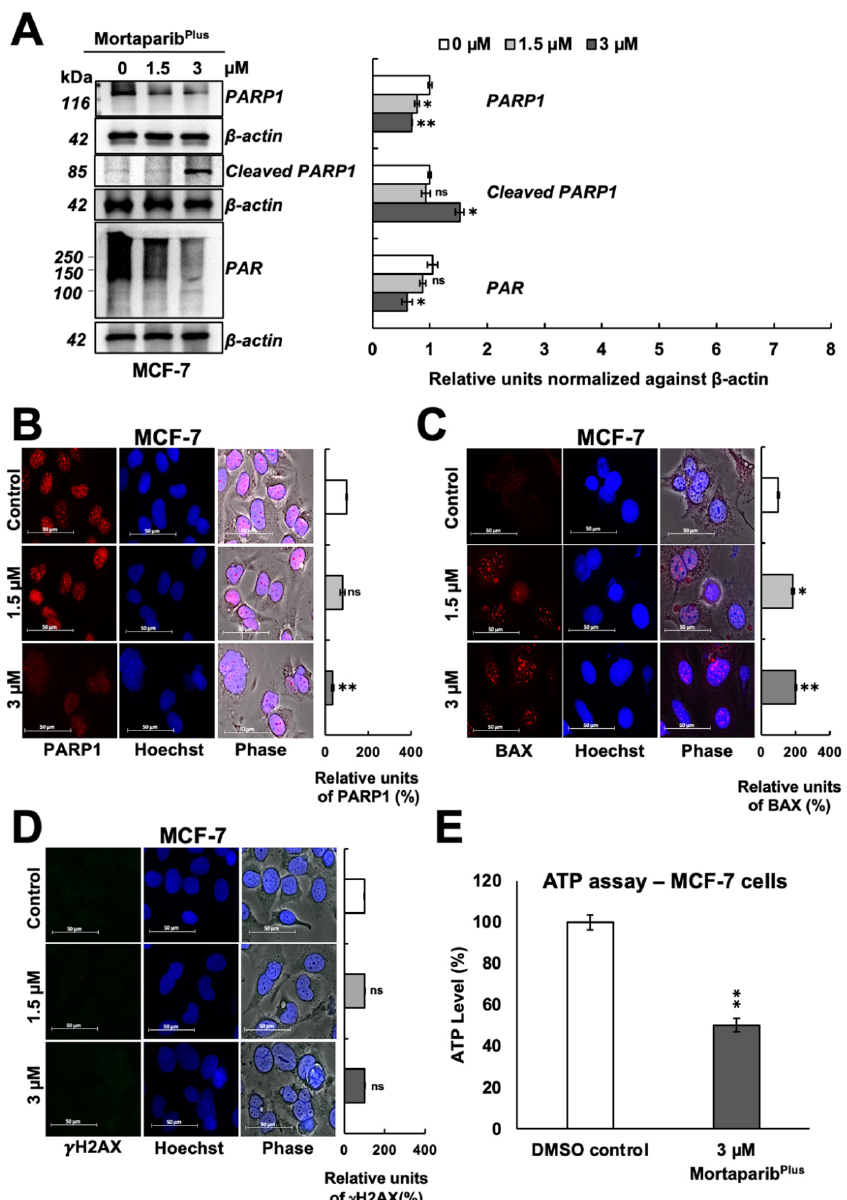
Figure 5. Mortaparib Plus -treated Luminal-A breast cancer cells (MCF-7 (p53 WT )) showed the molecular hallmarks of apoptosis. The levels of the full-length PARP1, the cleaved 89-kDa fragment of PARP1 and PAR polymer were analyzed in control and 48 h-Mortaparib Plus -treated MCF-7 cells by Western blotting ( A ). The levels of the full-length PARP1, BAX and the phosphorylated H2A histone variant X ( γ H2AX) proteins were measured by immunocytochemistry ( B–D ). A decrease in the levels of the full-length PARP1 and PAR polymer were observed in Mortaparib Plus -treated cells as compared to the untreated control. An increase in the 89-kDa cleaved fragment of PARP1 and BAX protein was observed in the Mortaparib Plus -treated MCF-7 cells if compared to the untreated control. Total cellular ATP concentrations in DMSO control and Mortaparib Plus -treated MCF-7 cells were measured using a luminescent ATP detection method ( E ). ATP levels were decreased in Mortaparib Plus -treated MCF-7 cells compared to the control untreated cells. Scale bar: 50 μ m. Full uncropped blots for the Western blotting experiments are shown in Supplementary Figures S15 and S16. The quantified data represents mean ± SD obtained from independent biological replicates; p -values were calculated using unpaired Student’s t -test. ns > 0.05, * ≤ 0.05 and ** ≤ 0.01 represent non-significant, significant, and very significant,